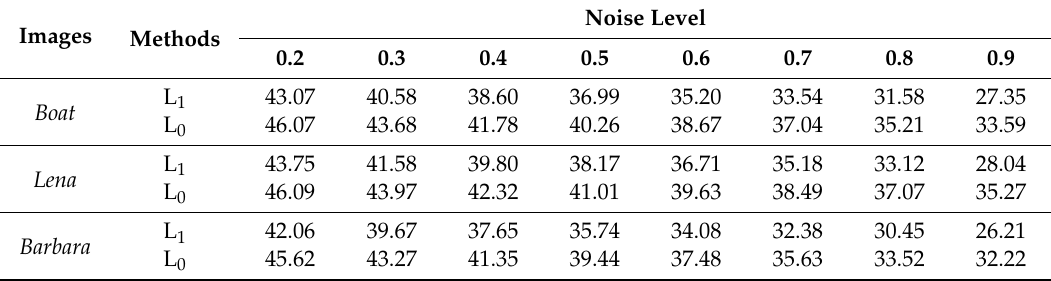
Table 3. MSSIM performance under the salt and pepper noise using FDCLP with L 1 or L 0 norms. Images